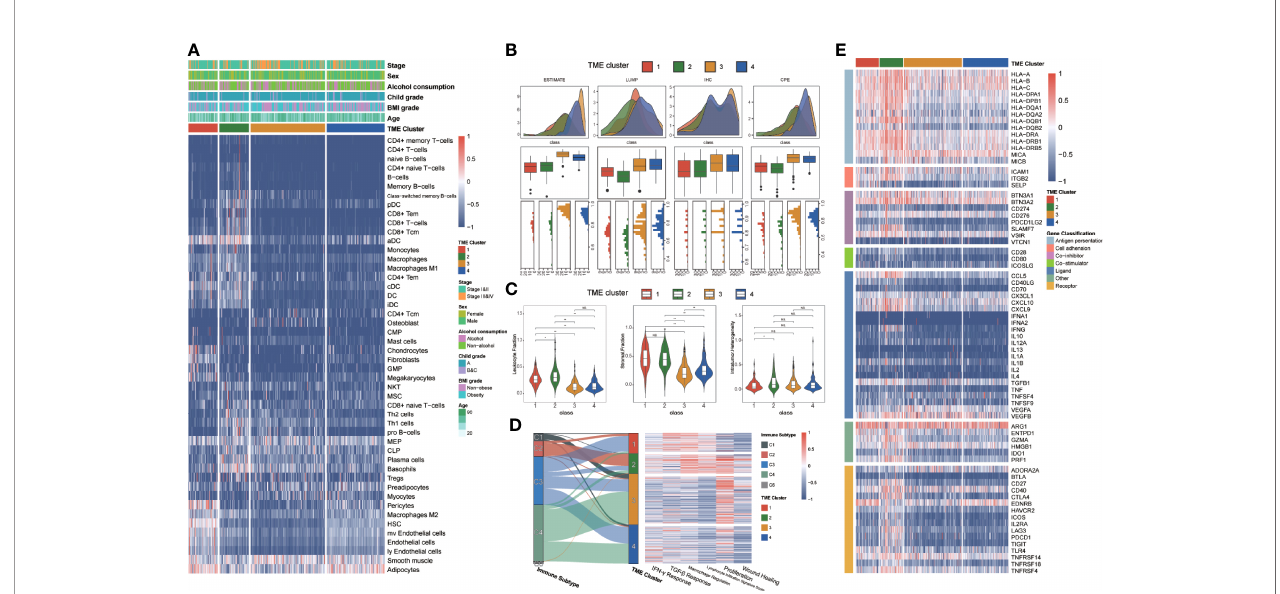
FIGURE 3 | The immune characteristics of different TME clusters. (A) Unsupervised clustering of TME cells for 370 patients in TCGA database. Clinical stage, sex, alcohol consumption, Child grade, BMI grade, age, and TME cluster were shown as patient annotations. (B) The boxplots showed the comparison of tumor purities with ESTIMATE, LUMP, IHC, and CPE, respectively. The thick line represents the median value. The bottom and top of the boxes were the 25th and 75th percentiles (interquartile range). The whiskers encompassed 1.5 times the interquartile range. The statistical difference of four groups was compared through the Kruskal – Wallis test. (C) Violin plots showed the comparison of immunocompetence with leukocyte fraction, stromal fraction, and intratumor heterogeneity respectively. The differences between every two groups were compared through the Kruskal – Wallis test. (D) Sankey diagram illustrates change between the immune subtype and TME cluster in each patient. Heatmap of IFN- g response, TGF- b response, macrophage regulation, lymphocyte in fi ltration, proliferation, and wound healing in different TME clusters. (E) Heatmap of immune genes that were differentially expressed in patients from different TME clusters. *p ≤ 0.05, **p ≤ 0.01, ns: p>